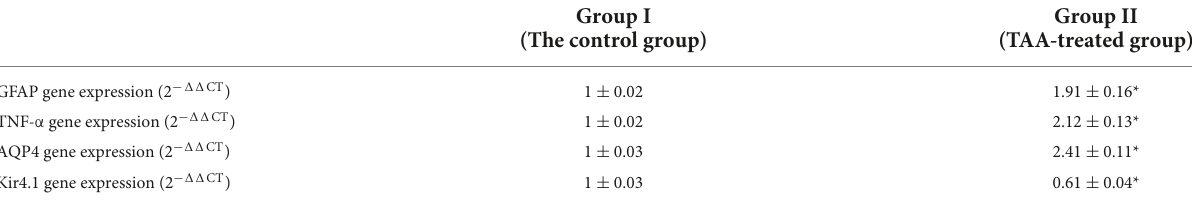
TABLE 3 mRNA expression of GFAP, TNF- α , AQP4, and Kir4.1 in cerebral cortex of control and TAA-treated groups.